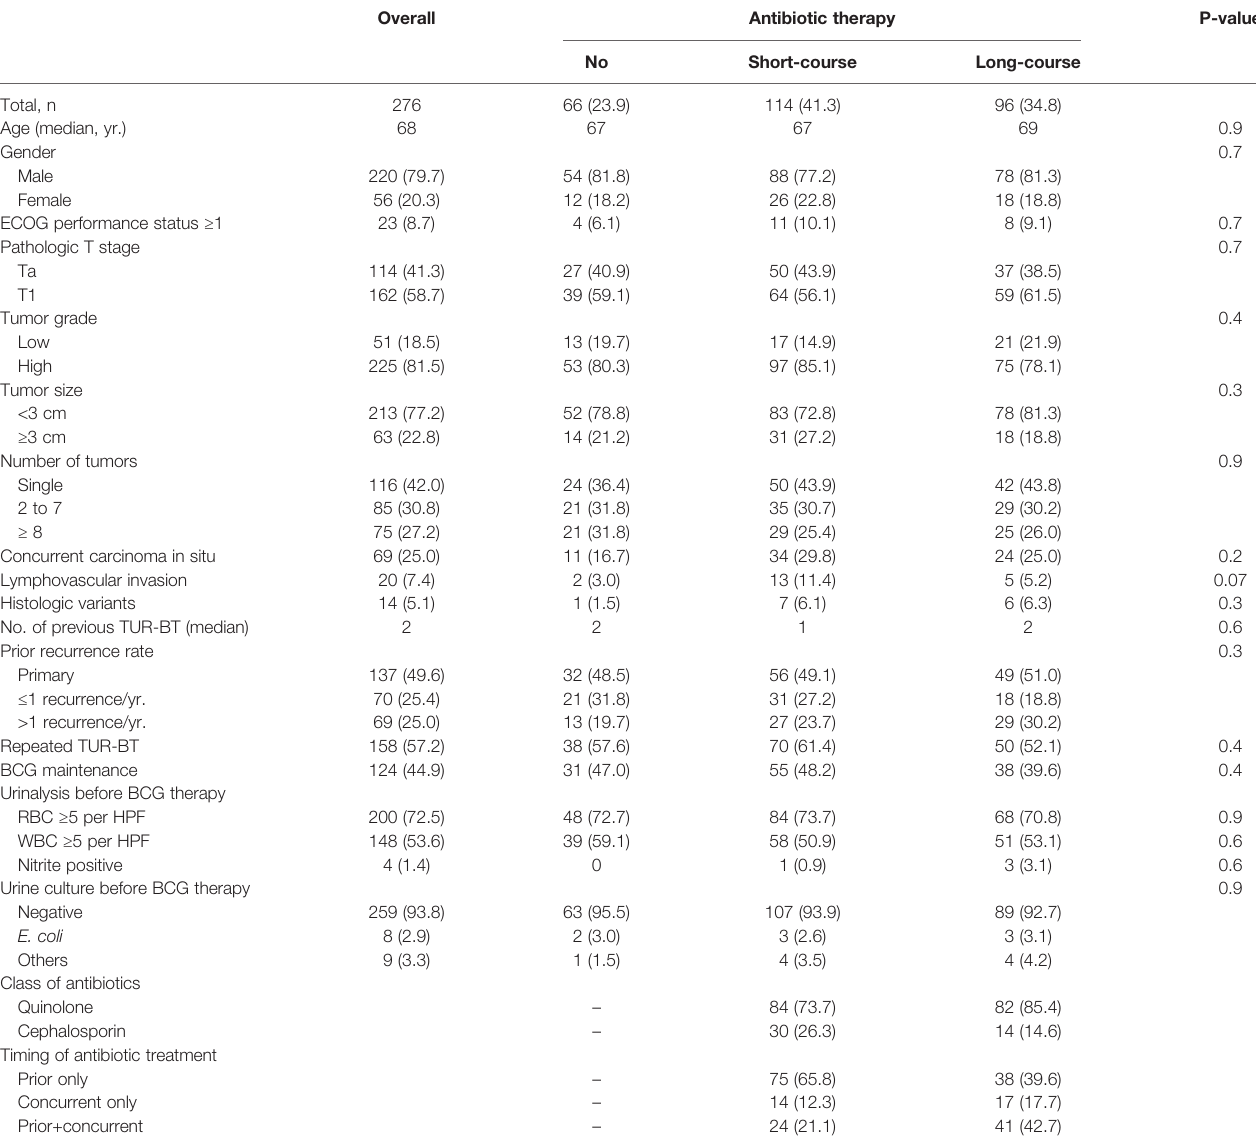
TABLE 1 | Baseline characteristics of